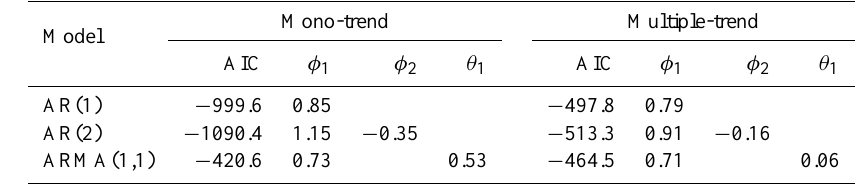
Table 1. AIC values and parameters calculated for each model tested.